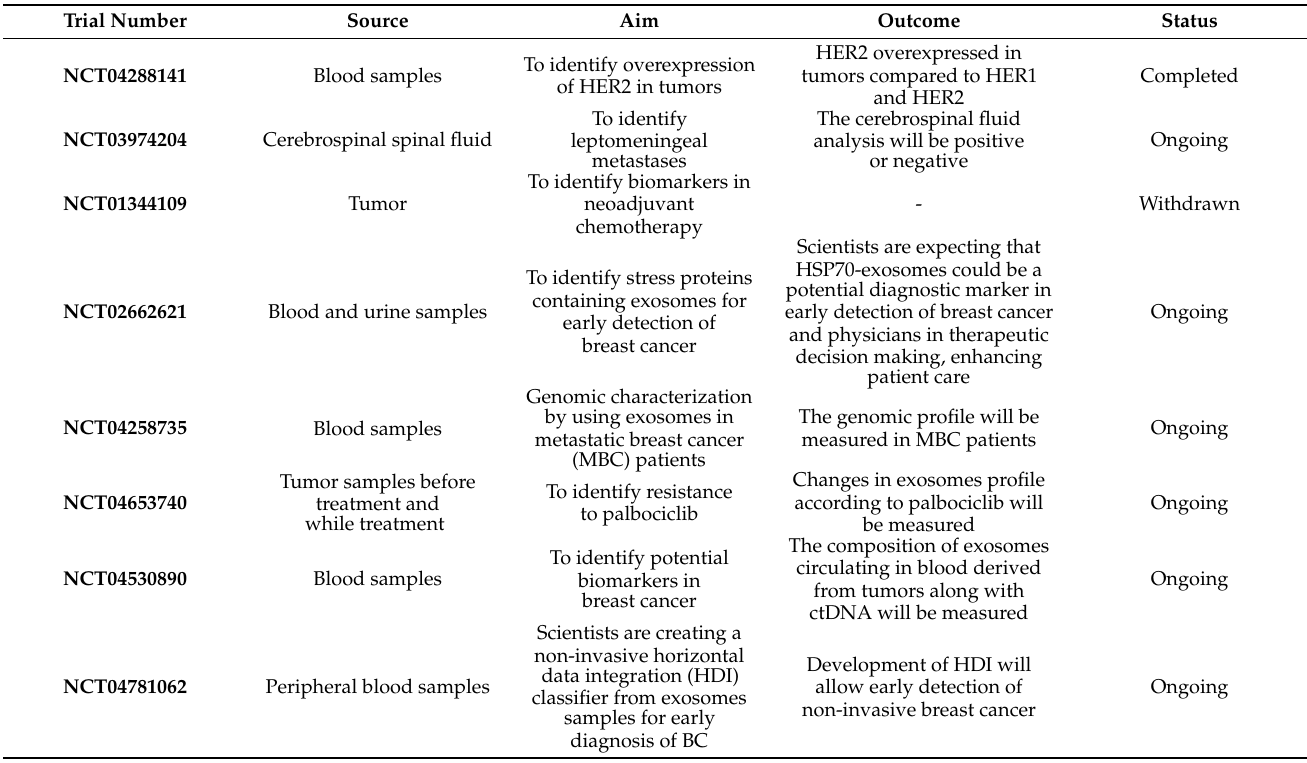
Table 7. A summary of clinical trials either focused on finding the suitable biomarkers for the early detection of breast cancer or as a delivery vehicle to access the therapeutic efficacy #